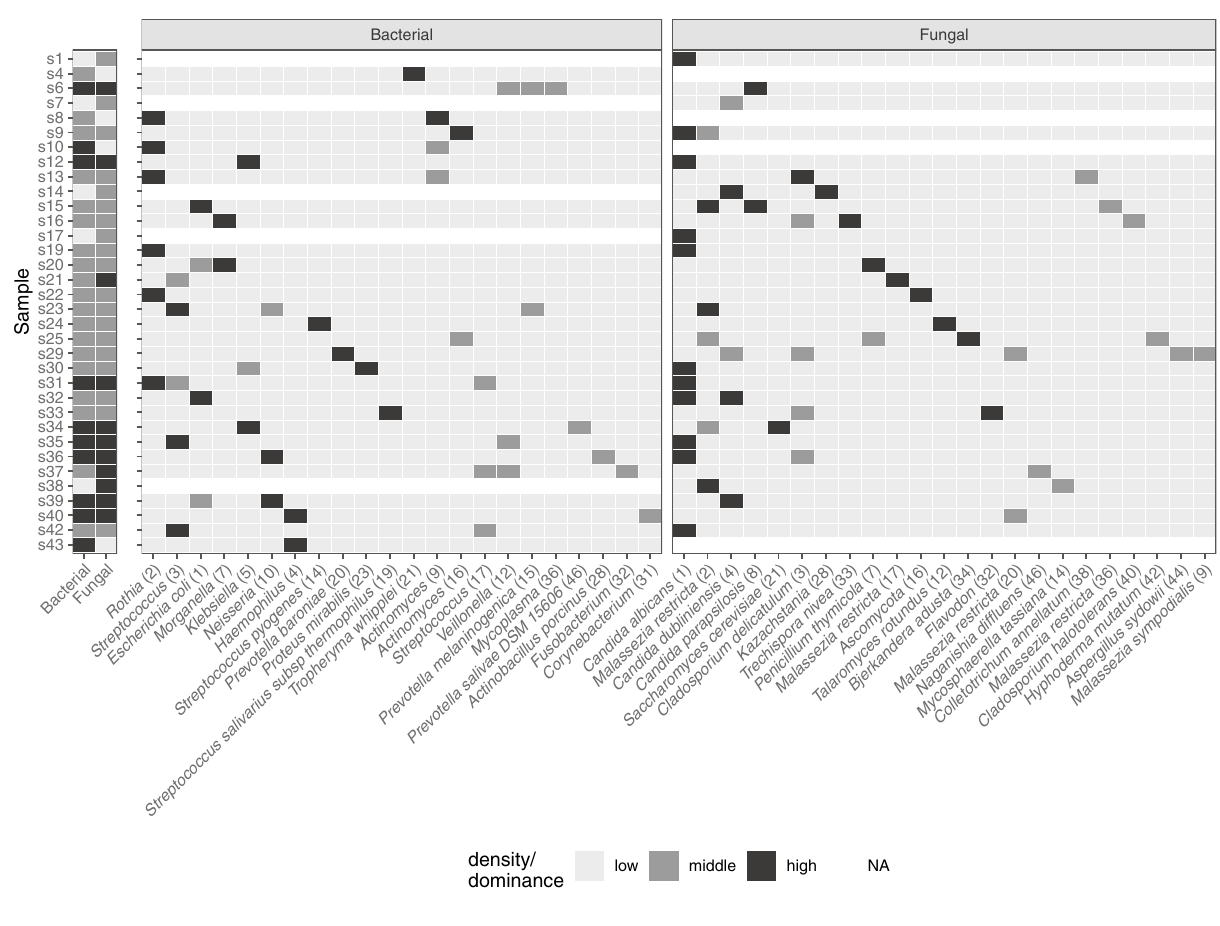
Figure 3. Heatmap depicting bacterial and fungal density and dominance of taxa on a per-sample basis. Only samples with a bacterial and/or fungal biomass higher than the 25th percentile are shown. Biomass data are shown by the first two columns; low (< 25th percentile), middle (25–75th percentile) or high (> 75th percentile). Relative abundance was stratified in low (< 15%), middle (15–30) and high (> 30%)-predominance. Only OTUs dominant (i.e. denoted ‘middle’ or ‘high’) at least in one sample were included (resulting in 23 bacterial OTUs and 25 fungal OTUs). Samples lacking any dominant OTU were not